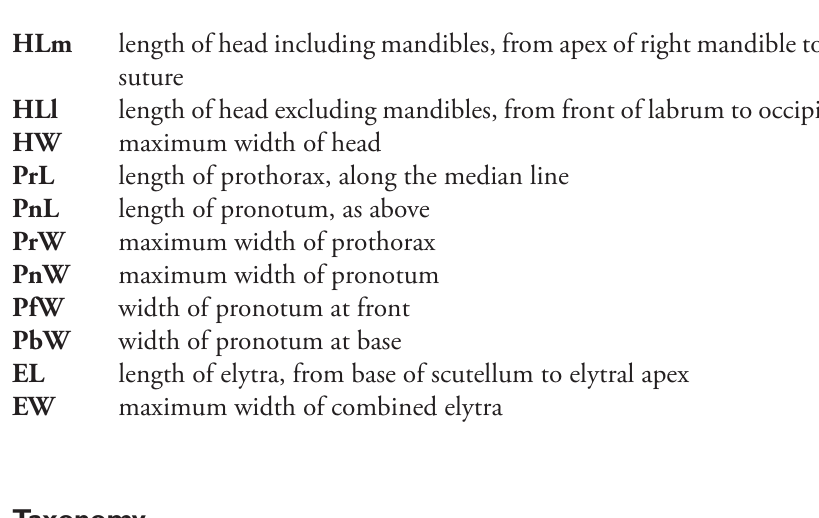
Abbreviations of other measurements used in the text are as